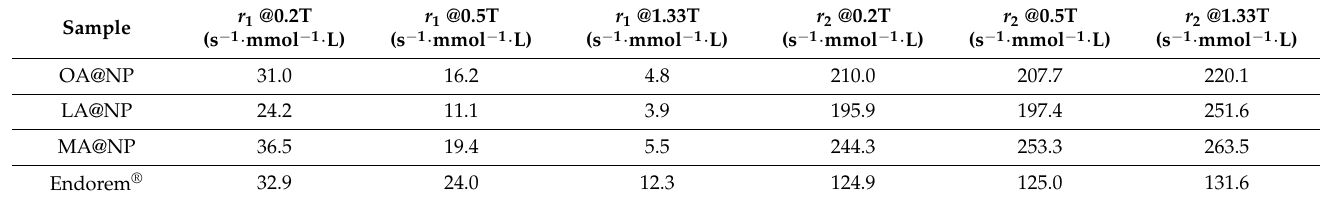
Table 3. Longitudinal ( r 1 ) and transverse ( r 2 ) relaxivities of fatty acid MNPs at given fields, H = 0.2 T, 0.5 T, and 1.33 T and for comparison of Endorem ® , withdrawn commercial